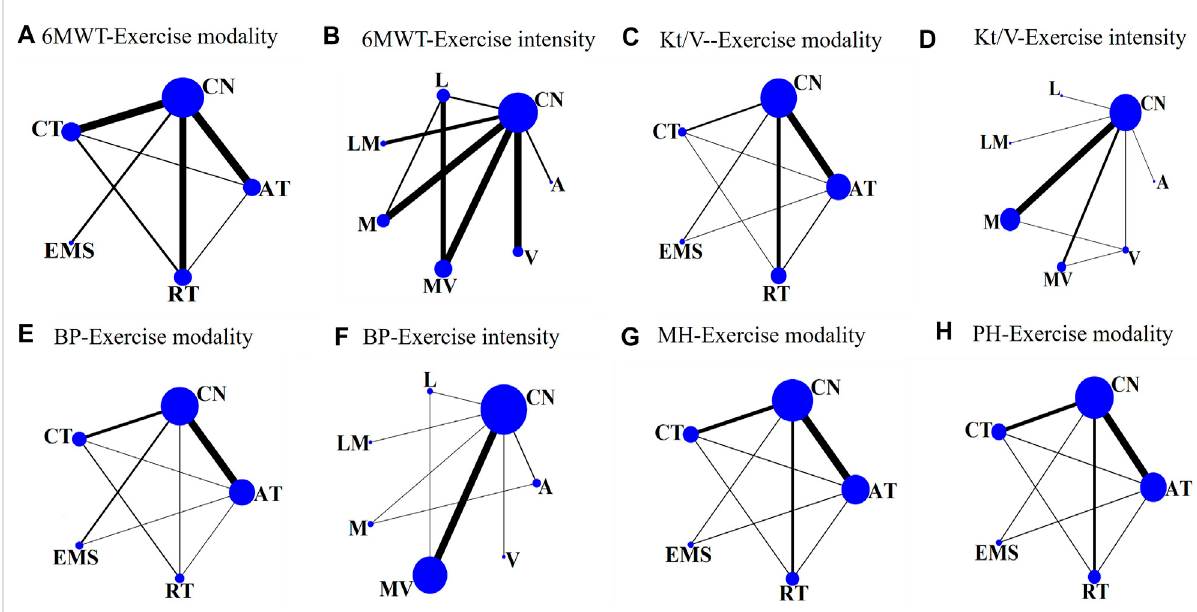
FIGURE 2 Networkplotsofclinicaltrialsforhemodialysispatientscomparingdifferentexercisemodalitiesorintensitiesto (A) :6MWT-exercisemodalities. (B) : 6MWT-exercise intensities. (C) Kt/V- exercise modalities. (D) : Kt/V-exercise intensities. (E) blood pressure-exercise modalities. (F) : blood pressure-exercise intensities. (G) : Mental health-exercise modalities. (H) Physical health-exercise